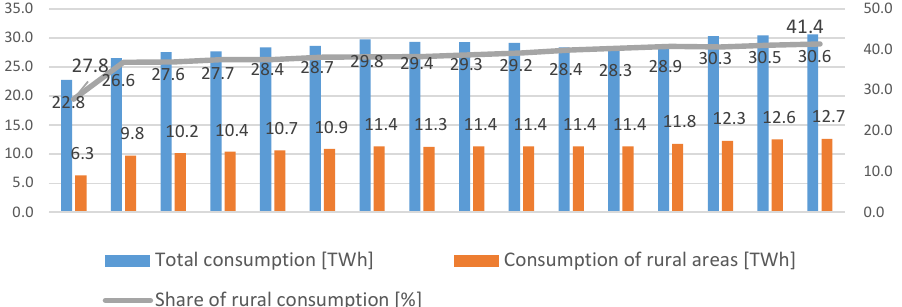
Figure 5. Electricity consumption in households in Poland in the years 2004–2019 (TWh). Source: [44]. Table 3. Dynamics of change in electricity consumption in Poland (GWh).